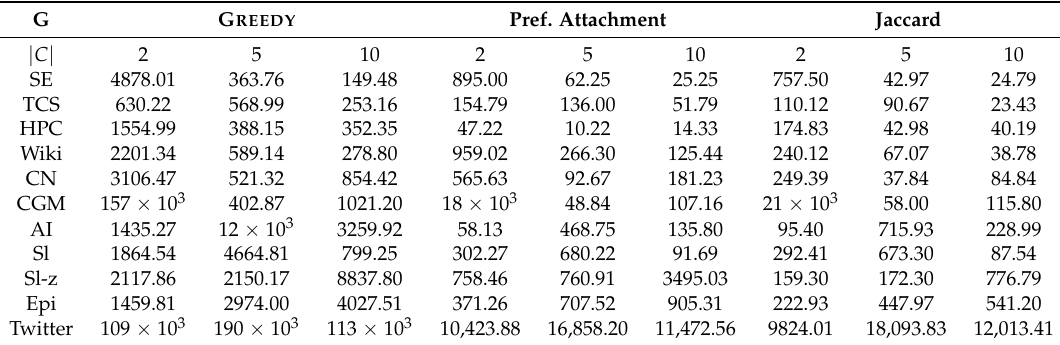
Table 3. Baseline results for real-world networks.